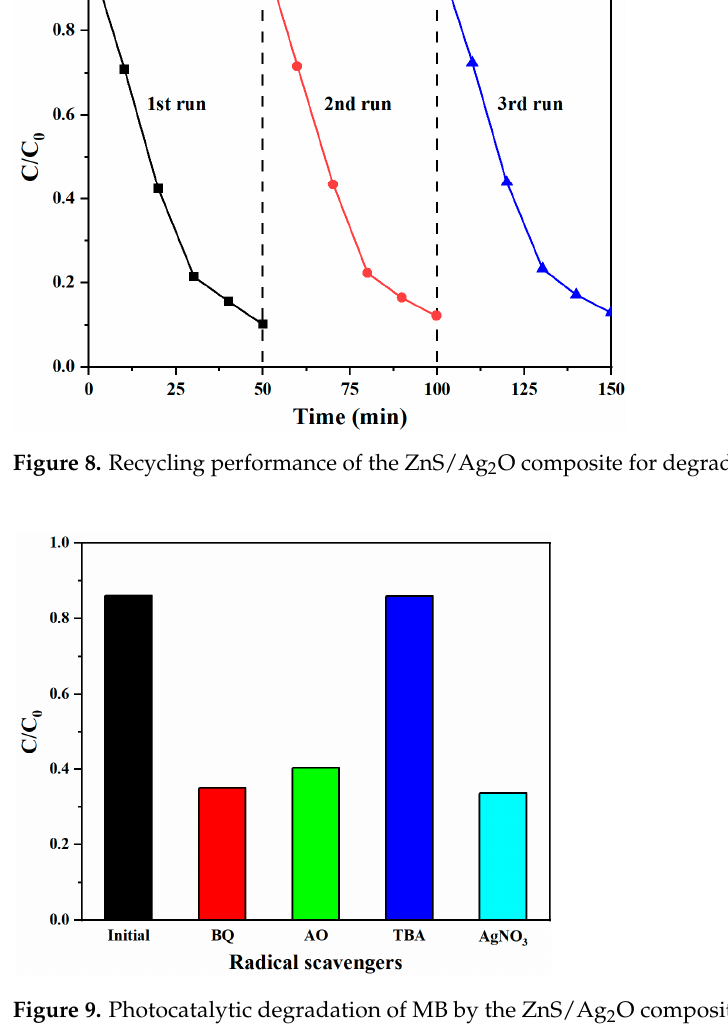
Figure 9. Photocatalytic degradation of MB by the ZnS/Ag 2 O composite alone and with different radical scavengers. Based on the above results, a possible mechanism for the enhanced photocatalytic activity of ZnS/Ag 2 O composite was proposed (Figure 10). The activity of a semiconductor photocatalyst mainly depends on the oxidation-reduction potentials of the valence band (VB) and conduction band (CB). Fermi level (E f , dashed line in Figure 10) is the chemical potential of thermodynamic equilibrium. Before n-type semiconductor ZnS and p-type semiconductor Ag 2 O formed the composite, their Fermi levels had different potentials. When the ZnS/Ag 2 O composite is formed and irradiated by UV-Vis light, the photogen- erated electrons are transferred from ZnS to Ag 2 O due to the initially higher CB potential